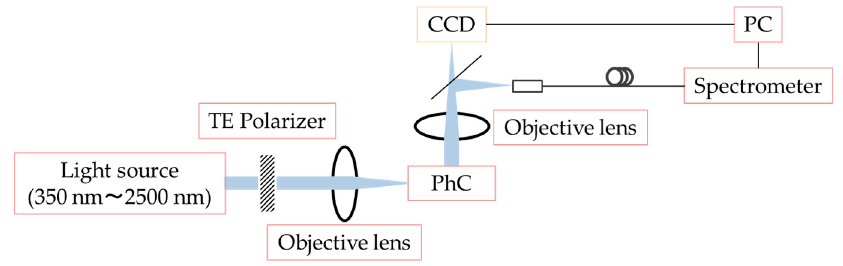
Figure 2. Optical setup used to detect resonant light. CCD, charge-coupled device; PC, personal Figure 2. computer, TE, Transverse Electric.